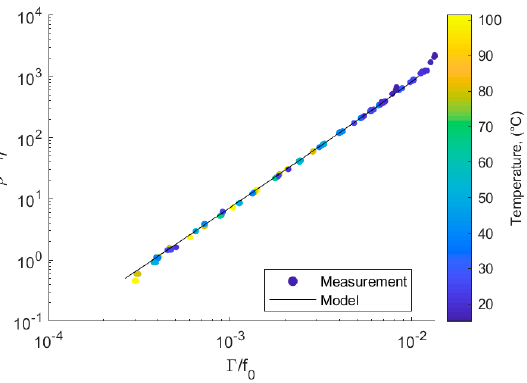
Figure 6. Numerical prediction and experimental measurements of the ρη value at different temperatures, where ρ is the density and η the viscosity.